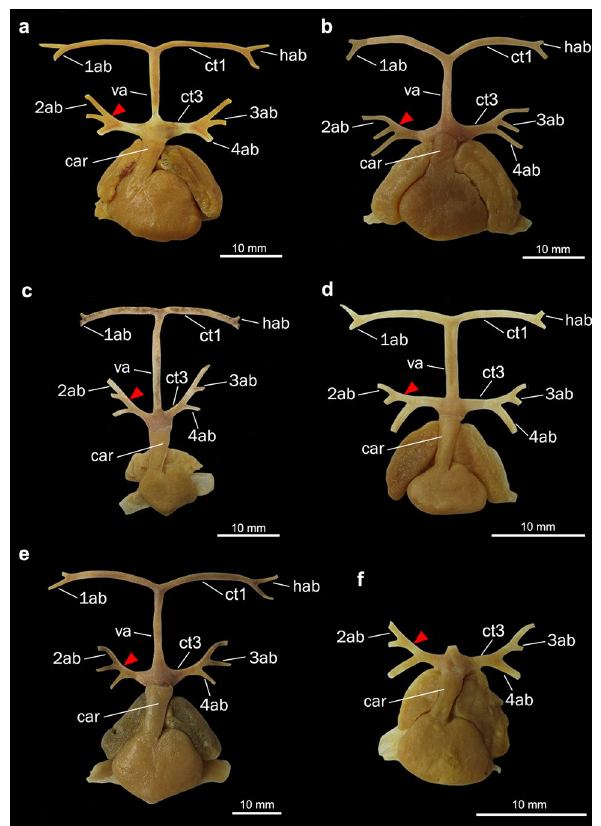
Figure 6. Heart and afferent branchial arteries in Rajiformes. ( a ) ventral view of Rajella purpuriventralis ; ( b ) ventral view of Zearaja chilensis ; ( c ) ventral view of Raja miraletus ; ( d ) ventral view of Malacoraja senta ; ( e ) ventral view of Dipturus sp.; ( f ) ventral view of Cruriraja rugosa , ventral aorta and two anteriormost afferent arteries not shown. 1ab-4ab 1st-4th afferent branchial arteries; car conus arteriosus ; ct1 common trunk from the ventral aorta to the hyoidean and first afferent branchial arteries; ct3 common trunk from the ventral aorta to the three posteriormost afferent branchial arteries; hab hyoidean afferent branchial artery; va ventral aorta. Red triangles point to the common vessel that originates the second and third afferent branchial